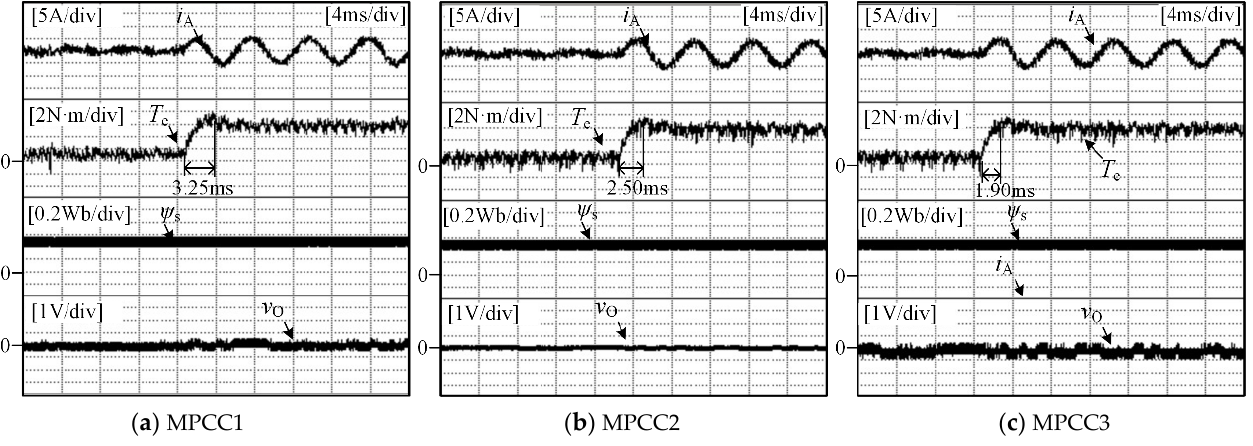
Figure 12. Experimental results of MPCC1, MPCC2 and MPCC3 (case 3).